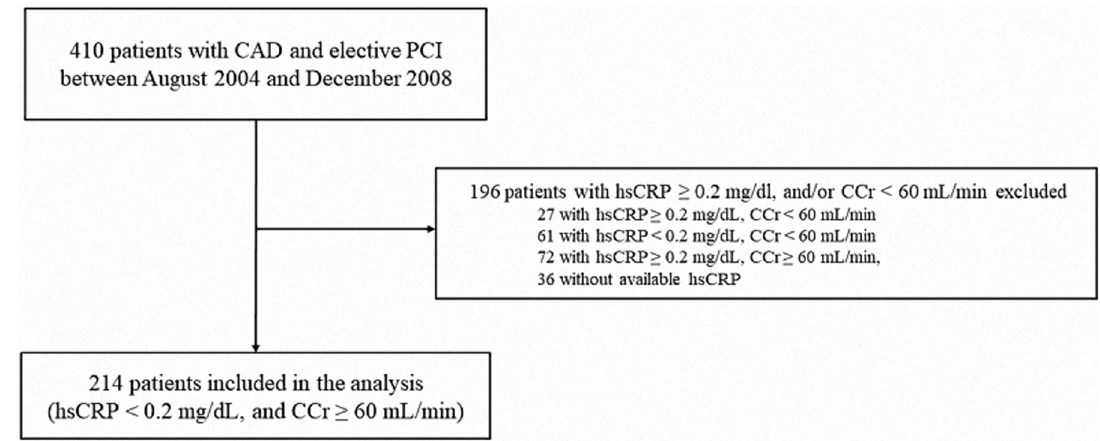
Fig 1. Study flow chart showing the disposition and outcome of 214 patients. Those with CCr < 60 mL/min and hsCRP � 0.2 mg/dL were excluded. During a median 5.1-year follow-up, 20 patients experienced MACCE. CAD, coronary artery disease; PCI, percutaneous coronary intervention; hsCRP, high-sensitivity C-reactive protein; CCr, creatinine clearance; MACCE, major adverse cardiac or cerebrovascular events; ACS, acute coronary syndrome; CHF, congestive heart